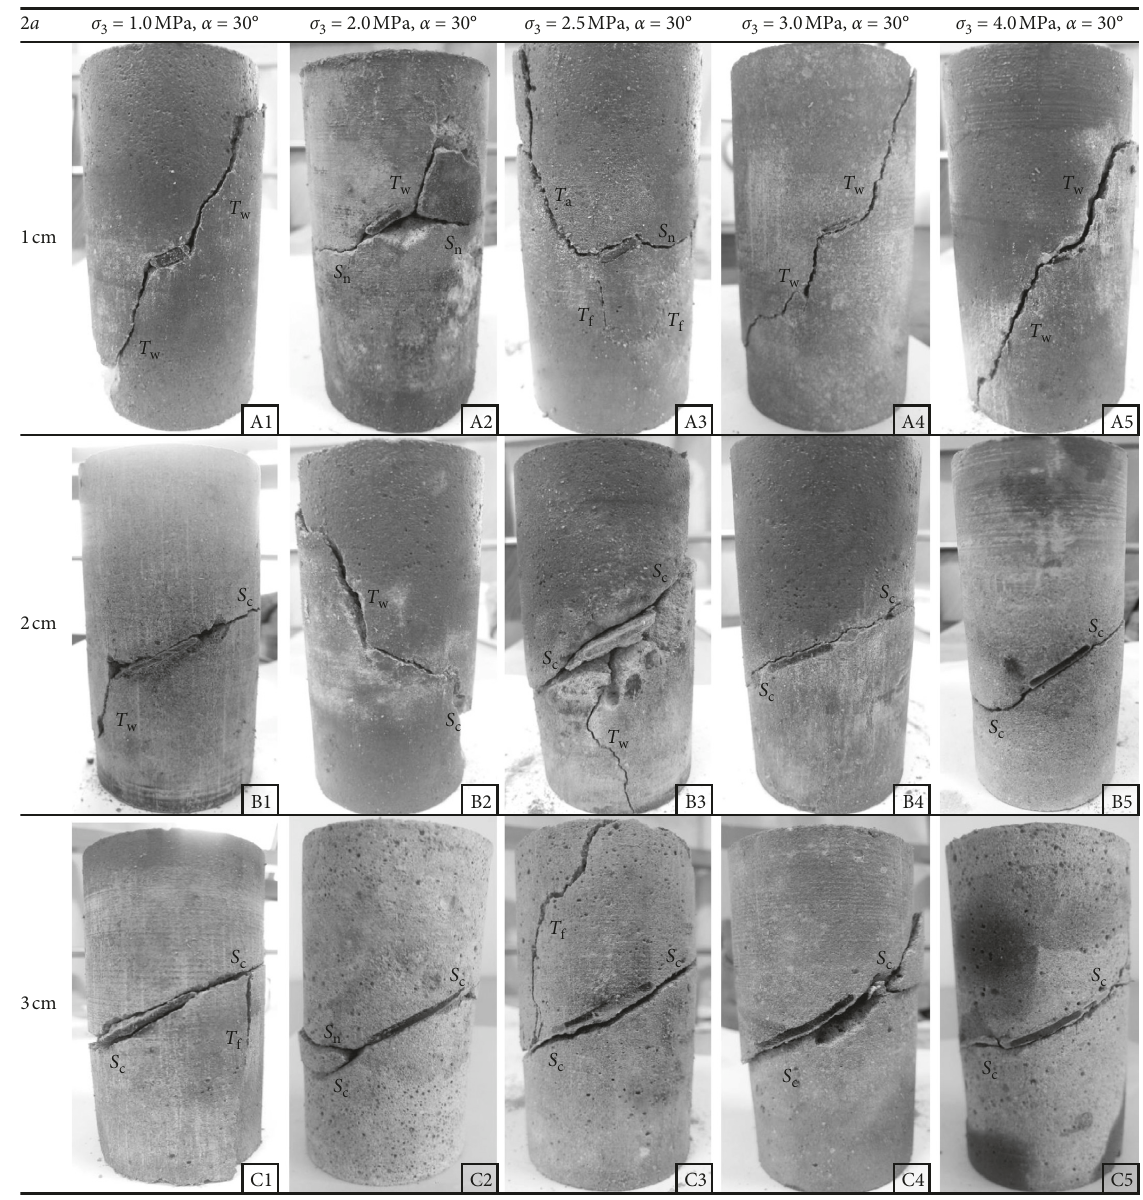
Figure 5: Failure modes of the specimens with a grout-infilled flaw having an inclination angle of 30 ° and different flaw